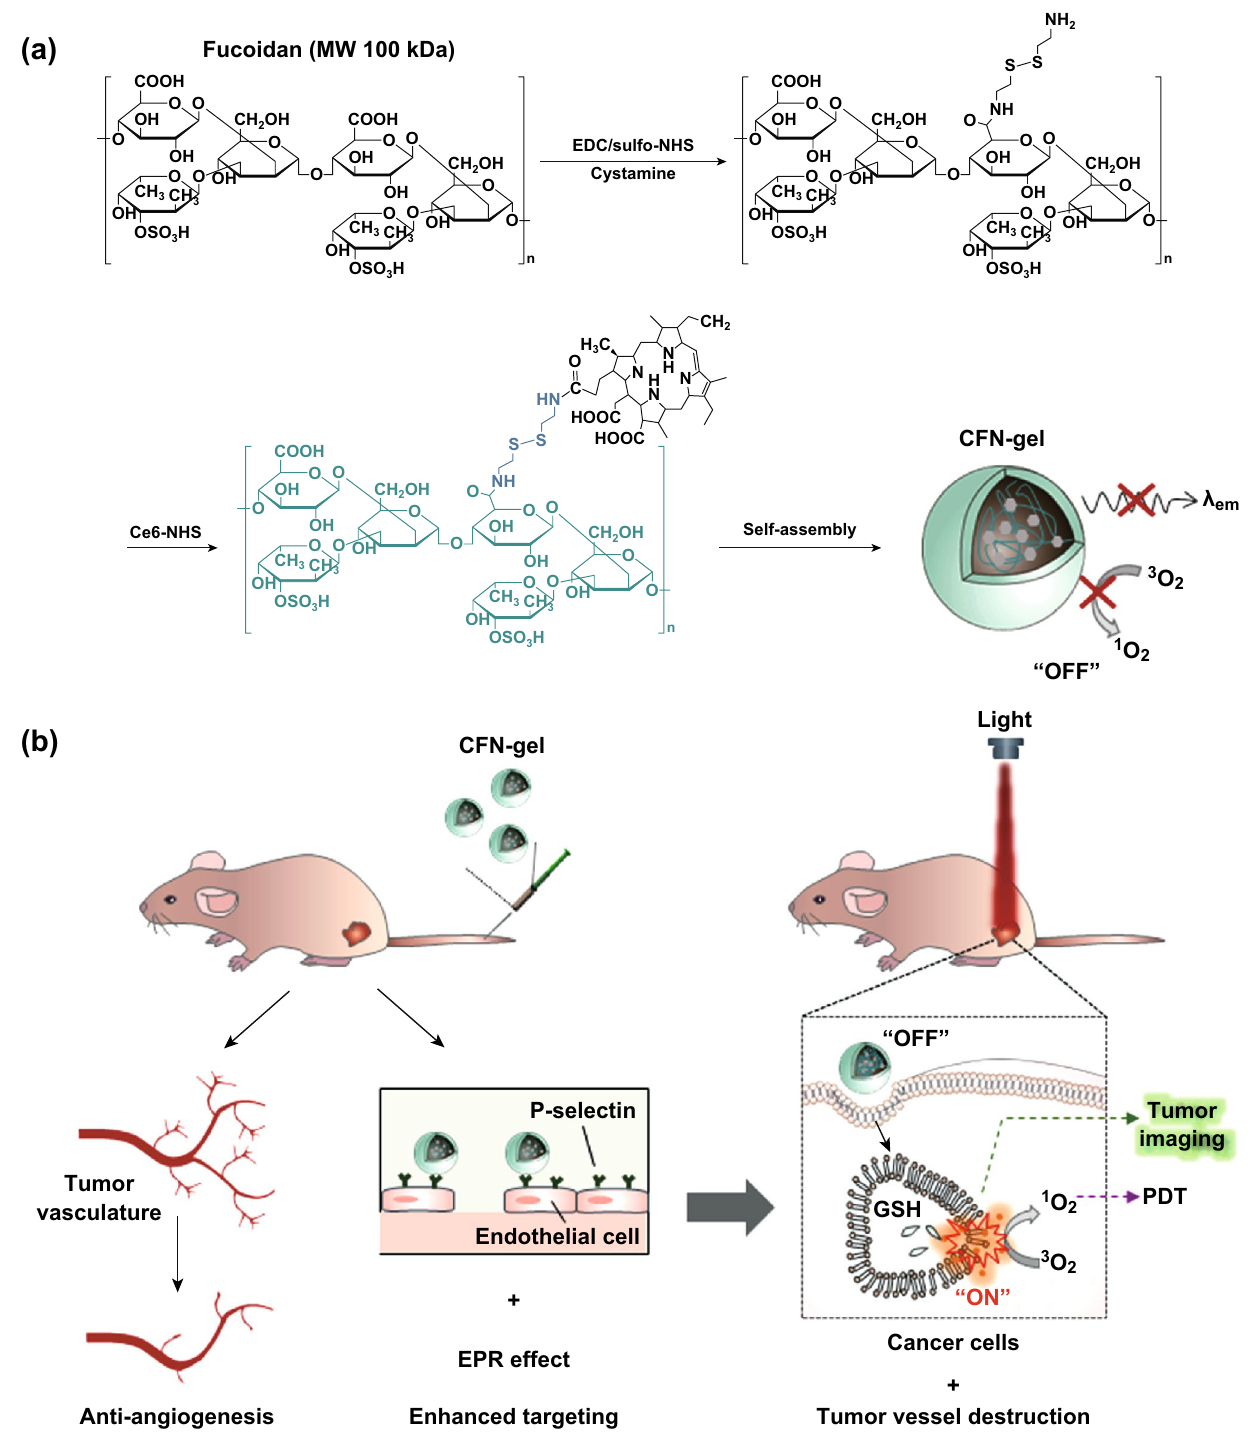
Fig. 1 a Synthetic steps of Ce6–fucoidan theranostic nanogel (CFN‑gel), b schematic illustration of CFN‑gel and its mode of